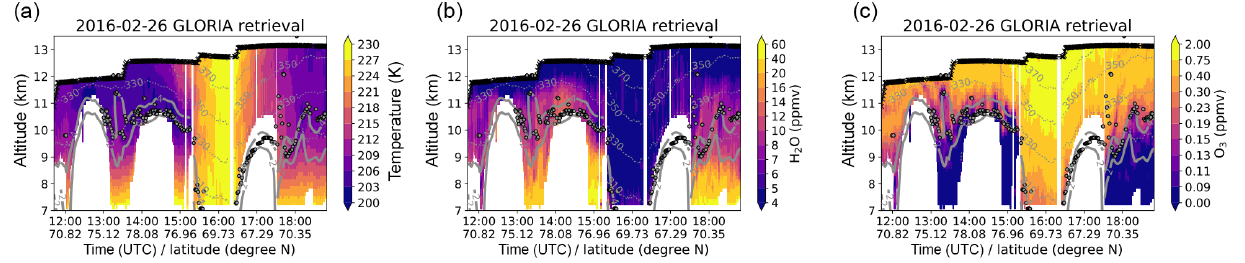
Figure 10. Retrieval results derived from GLORIA measurements taken on 26 February 2016. Panel (a) shows temperature, panel (b) shows water vapor, and panel (c) shows ozone. Thick solid lines shows ECMWF potential vorticity, dotted lines shows potential temperature, and big dots show the location of the thermal